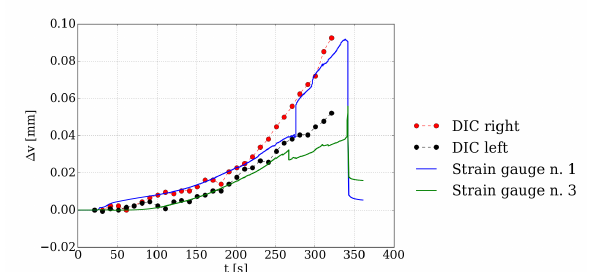
Figure 12: Comparison between the vertical displacements ob- tained by the DIC method and the strain gauges measurements for sample n. 2.